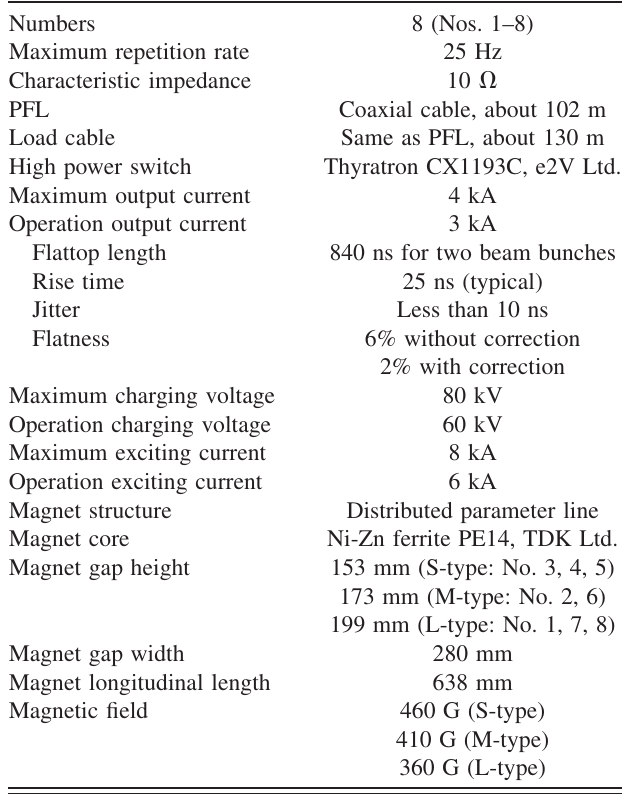
TABLE I. Specifications of the RCS kicker system.